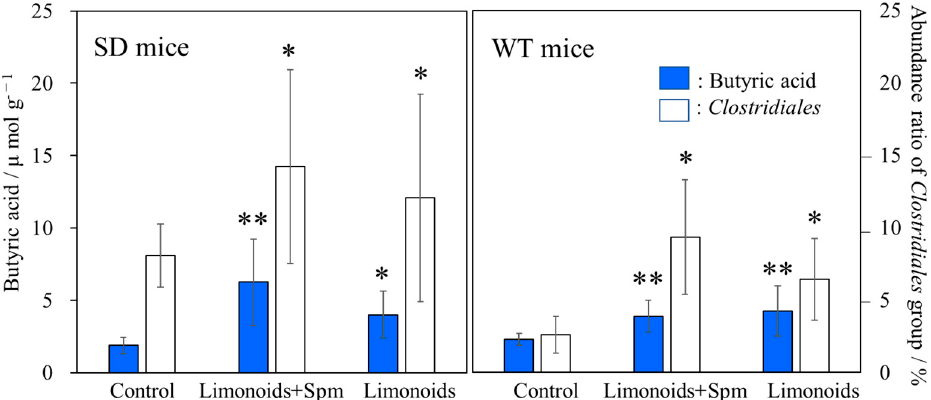
Figure 8. Comparison of the amount of butyric acid in feces from SD or WT mice ( µ mol g − 1 ) and relative abundance (%) of bacteria ( Clostridiales groups) identified from Figure 7 as promoting butyric acid metabolism. Values represent mean ± S.D. Data onto a bar graph are plotted in comparison to the controls for clarity; * p ≤ 0.05; ** p ≤ 0.01. The correlation coefficient between the relative abundance (%) of the Clostridiales groups and the amount of butyric acid, r = 0.72, p < 0.01. SD, Sandhoff disease; WT, wild-type.